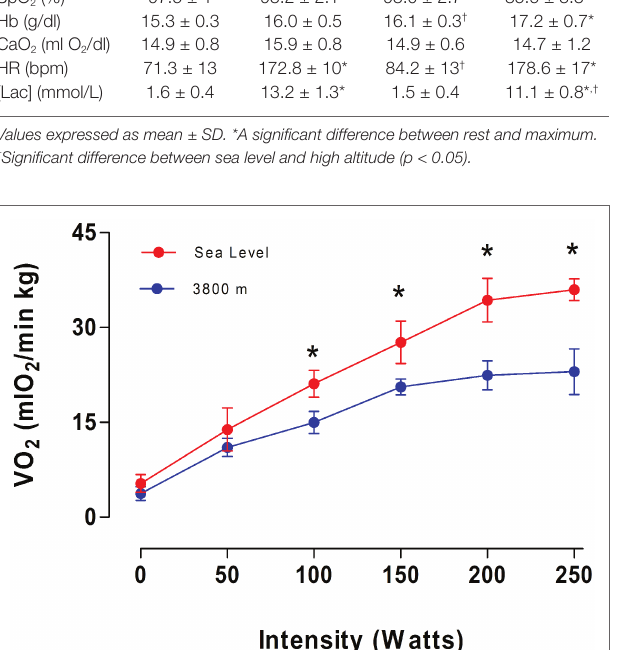
FIGURE 2 | Average values of oxygen consumption (VO 2 ) as a function of intensity (in W) obtained on the fourth day at sea level and 3,800 m. * represents a significant difference between Sea level vs. 3,800 m ( p < 0.05).